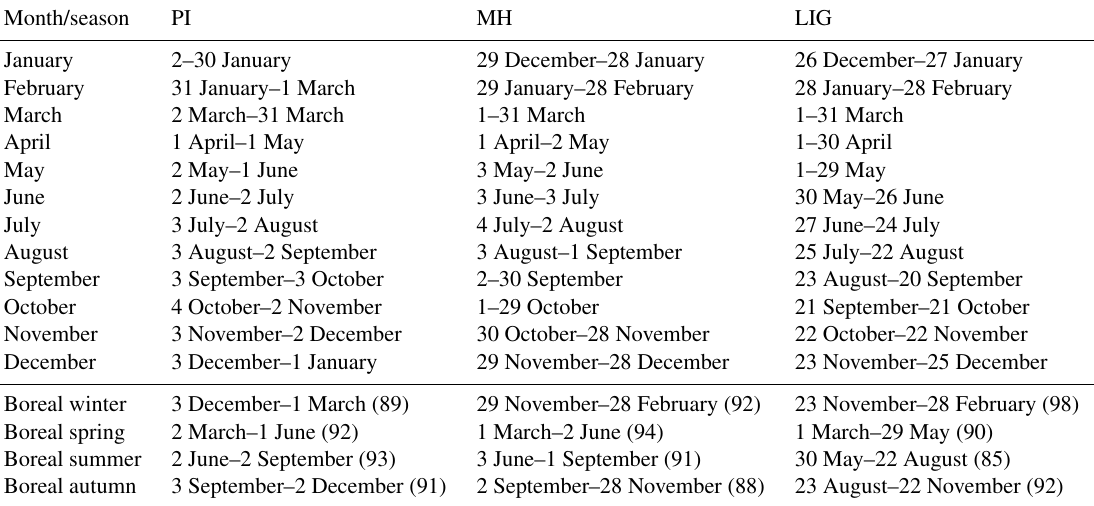
Table 3. Starting and end date of angular month in PI, MH, and LIG, referencing today’s classical calendar in a no-leap year, calculated based on the approach described in Sect.